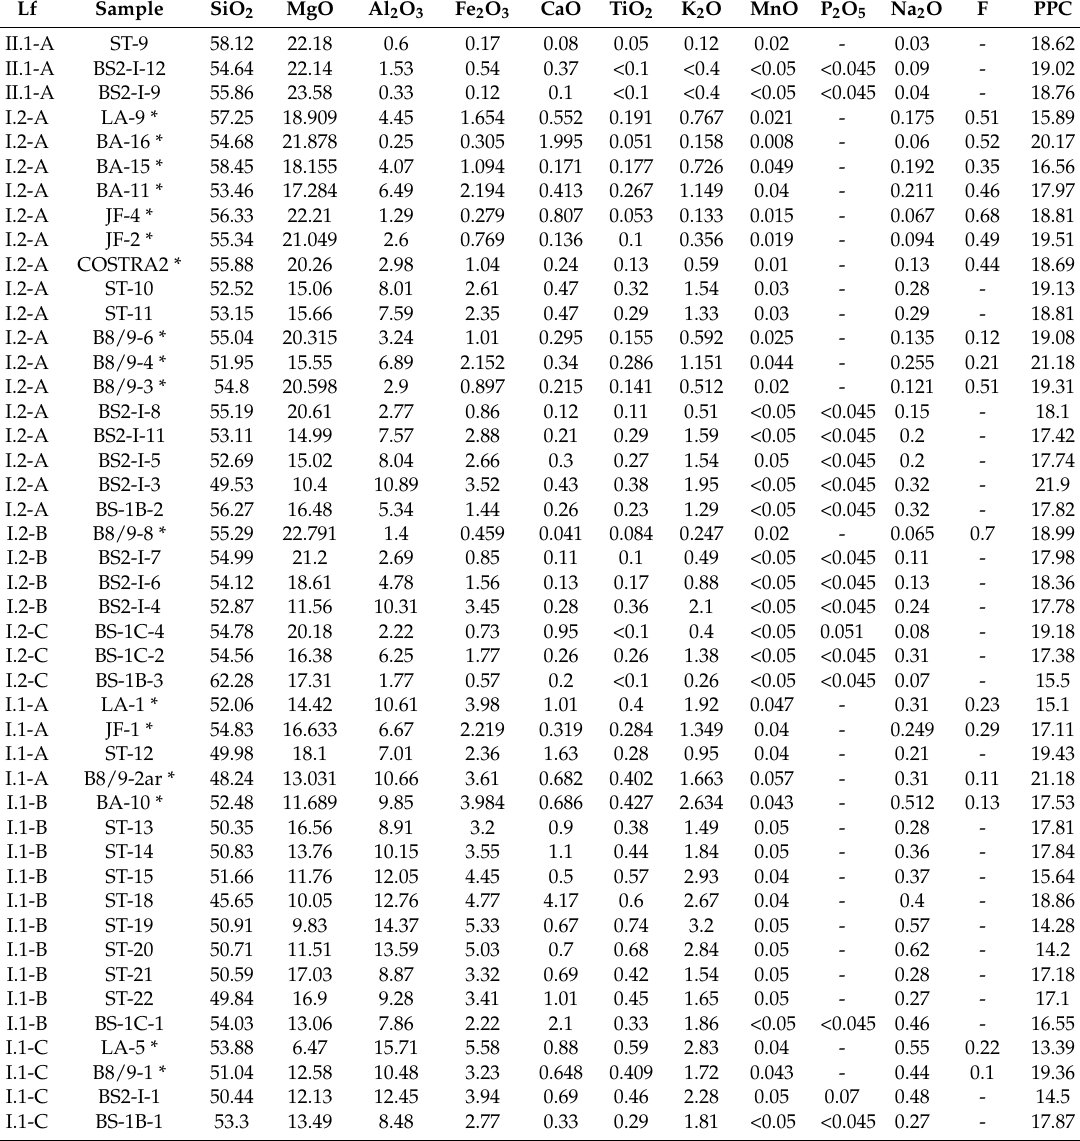
Table A1. Chemical analysis of major elements (%w/w) of samples from Units I and II.